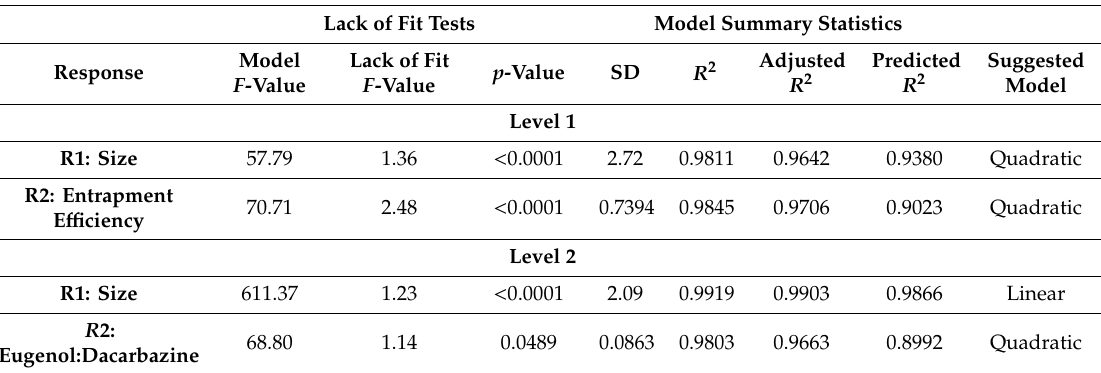
Table 5. Analysis of Variance (ANOVA) Analysis.